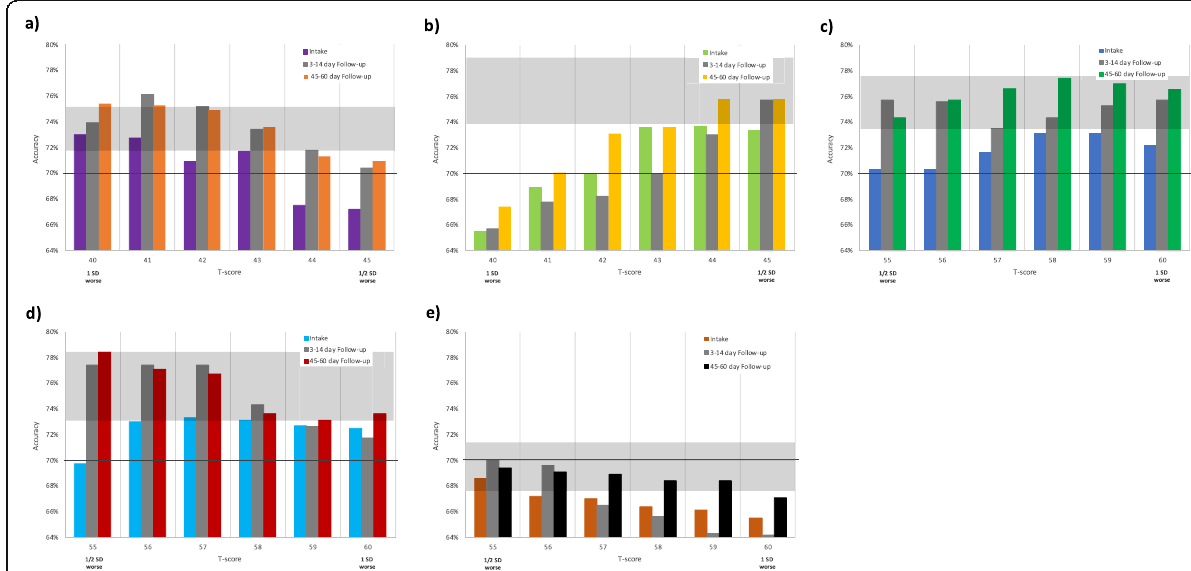
Fig. 2 Accuracies for the five PROMIS measures ’ ability to discriminate patient acceptable symptom state (PASS) across the three time points for all whole-number T-score thresholds from ½ to 1 standard deviation worse than the reference population mean score of 50: (a) Physical Function, (b) Self-Efficacy for Managing Symptoms, (c) Pain Interference, (d) Fatigue, (e) Depression. Gray strip indicates range of “ optimal ” T- score threshold accuracies for that PROMIS measure. Black horizontal line at minimum acceptable accuracy